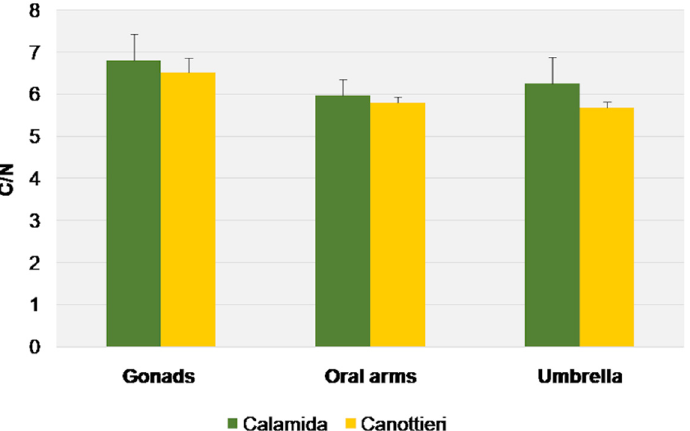
Figure 13. C/N molar ratio (average + S.E. as vertical bar) in the gonads, oral arms, and umbrella of Cassiopea andromeda individuals collected at the two sites of Cala.